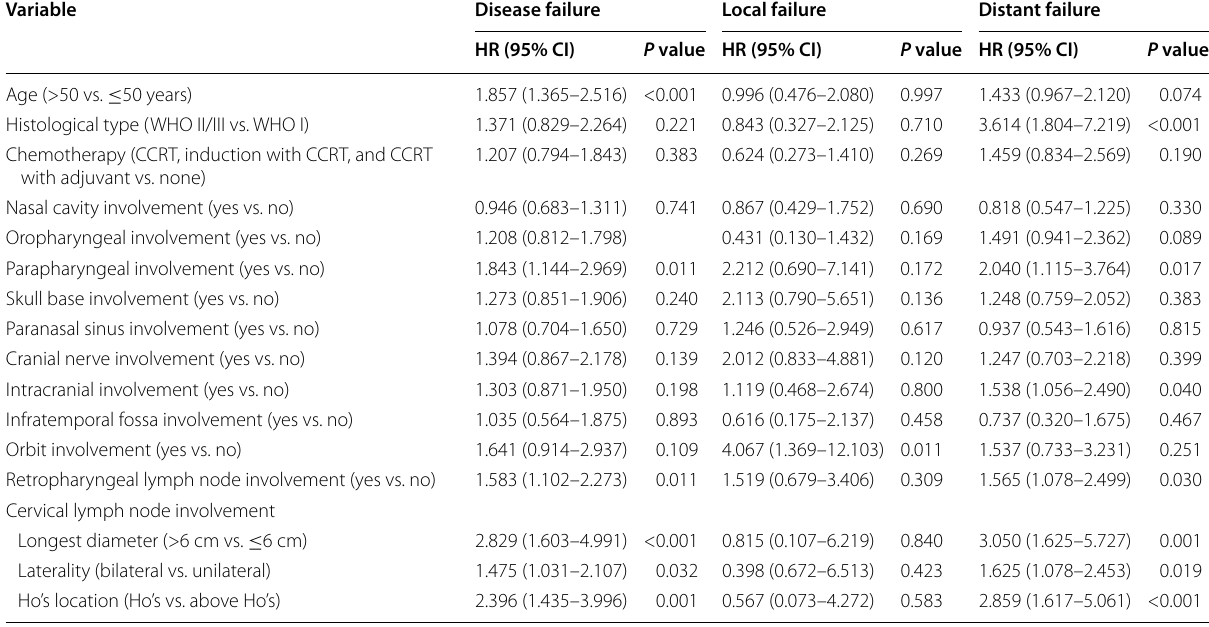
HR hazard ratio, CI confidence interval, CCRT current